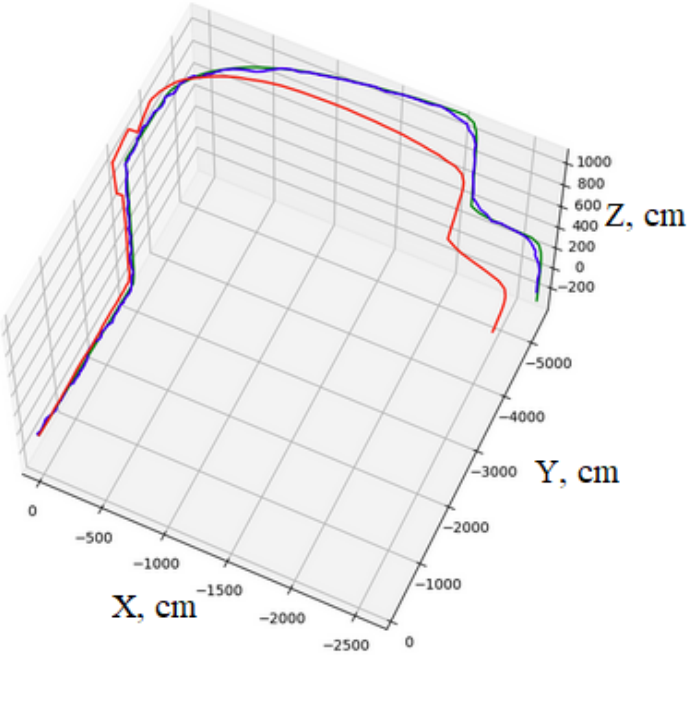
Figure 3. Kalman filtration applien to the trajectory estimation by visual odometry. Green— groundtruth, red—pure VO, blue—VO +